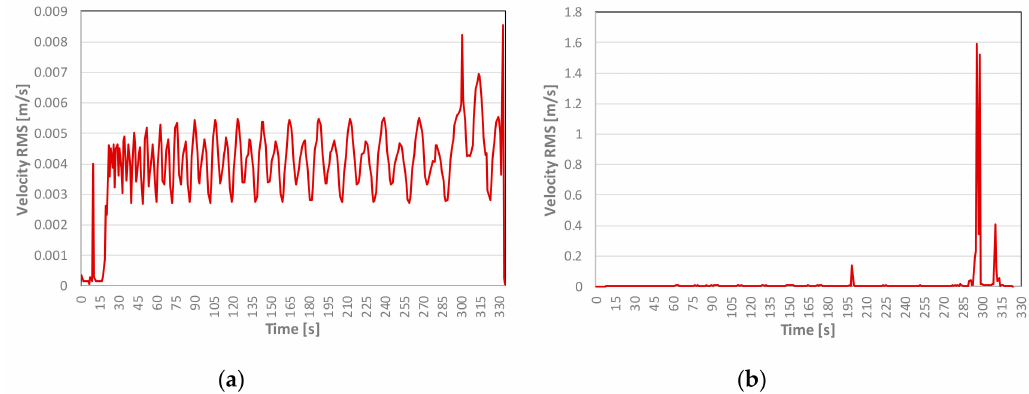
Figure 6. Vibrations amplitude on PVD coated inserts for the group of tests of ( a ) PH7930-S1 and ( b ) PH7930-S2 cutting